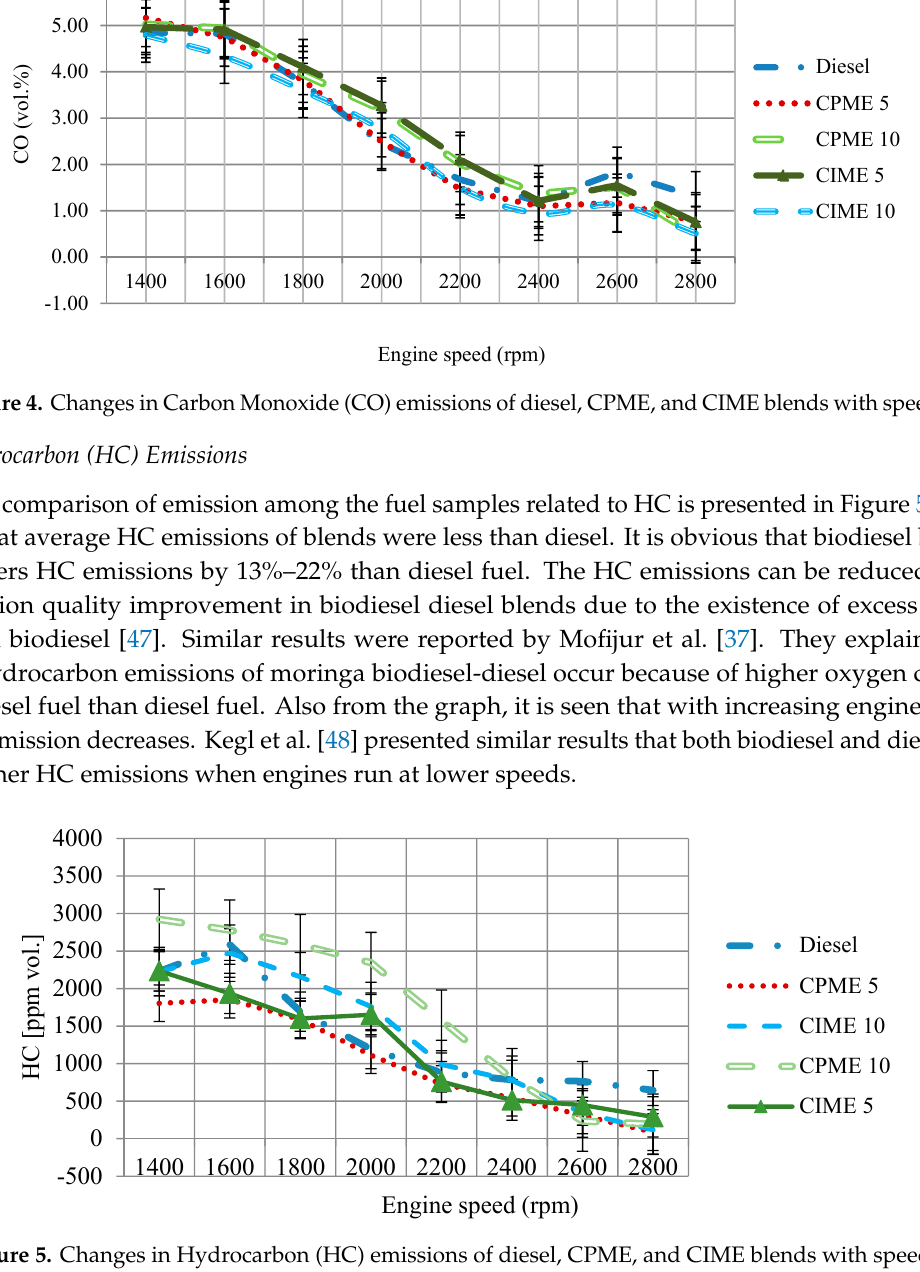
Figure 3. Changes in Nitrogen Oxide (NO x ) emissions of diesel, CPME, and CIME blends with speeds.